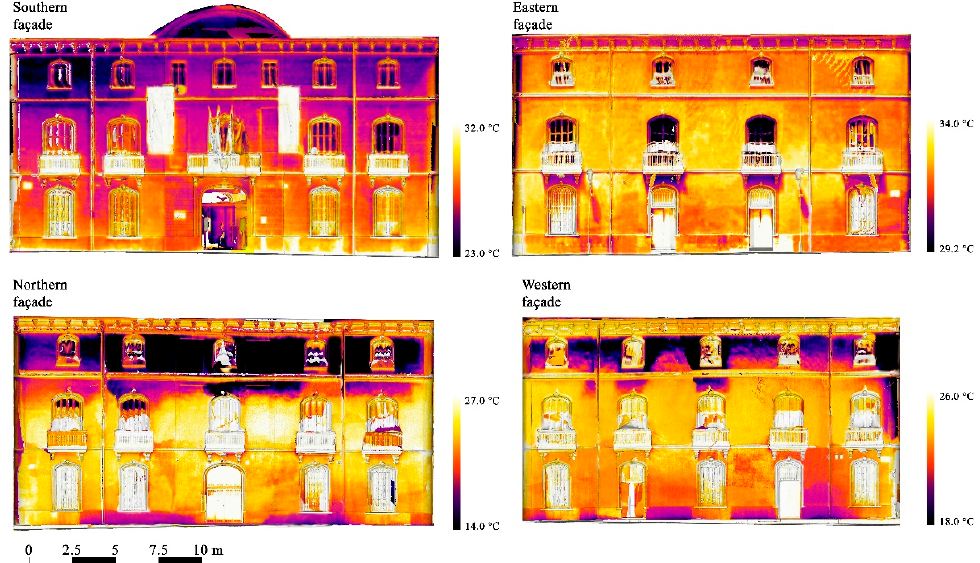
Figure 11. Orthophotos achieved from the integration of the 3D mesh derived from the LiDAR point cloud and projected TIR images after the mosaicking process, aimed at the generation of a thermal texture.